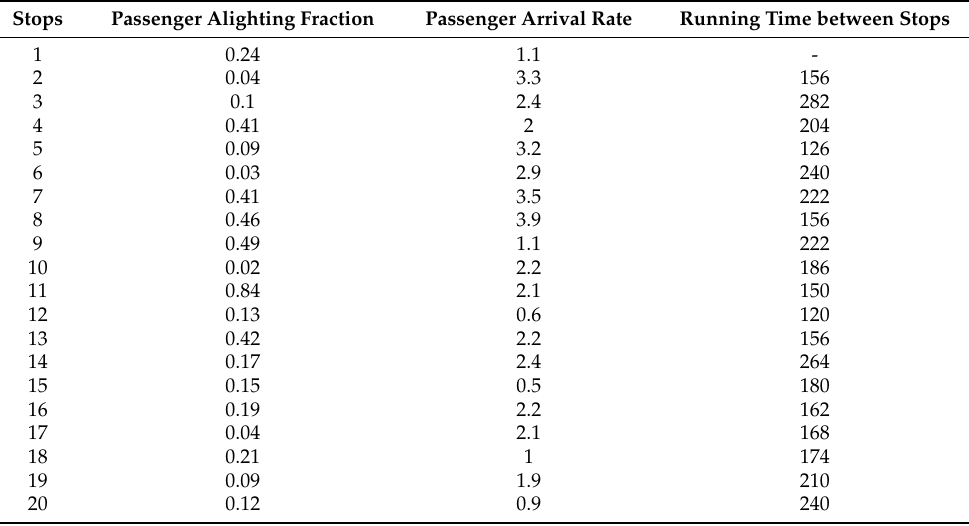
Table A2. Values of stochastic parameters in scenario